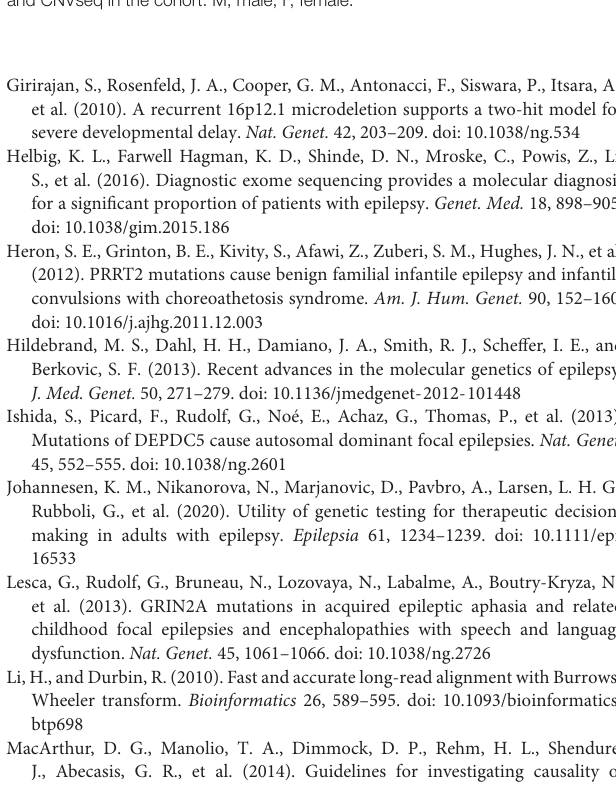
Supplementary Table 3 | Clinical and molecular features of patients with variants of uncertain significance (VUS) identify in the cohort. M, male; F, female; Y, year(s); M, month(s); D, day(s); AR, autosomal recessive; AD, autosomal dominant; P, positive; N, negative; nd, not determined. Supplementary Table 4 | Clinical and molecular features of patients with de novo variants identified in the negative cohort. M, male; F, female; Y, year(s); M, month(s); D, day(s); AR, autosomal recessive; AD, autosomal dominant; XLD, X-linked dominant; XLR, X-linked recessive. Supplementary Table 5 | Sequencing data quality of whole-exome sequencing and CNVseq for the patients and their parents. CNVseq, copy number variant